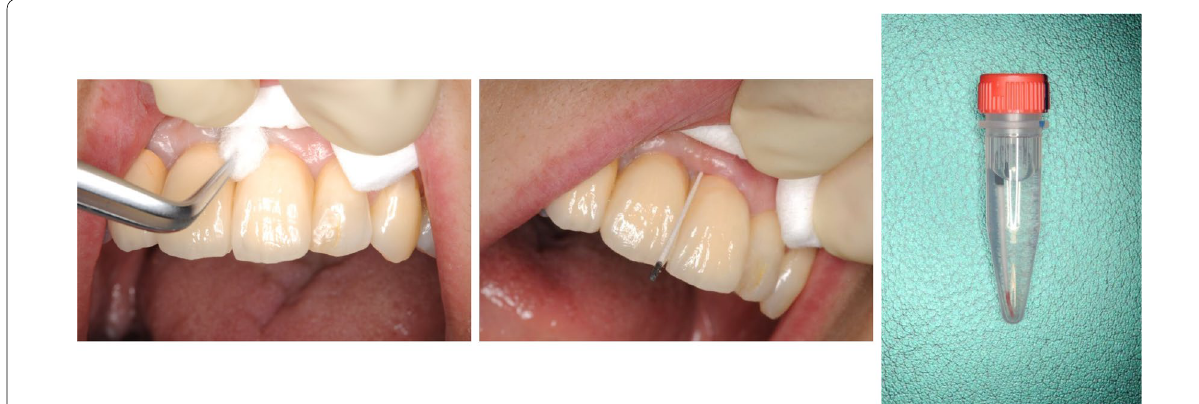
Fig. 1 Paper point method for sampling periodontal